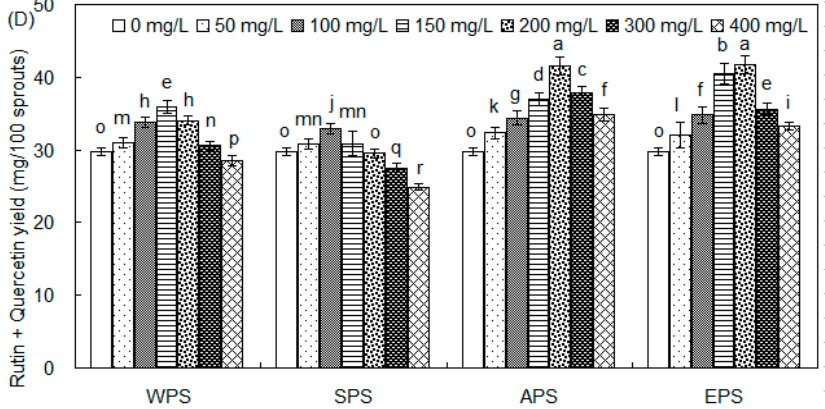
Figure 2. Effects of WPS, SPS, APS and EPS (0, 25, 50, 100, 200 and 400 mg/L) of endophyte F. oxysporum Fat9 on the total flavonoid content ( A ), rutin content ( B ), quercetin content ( C ), and total rutin and quercetin yield ( D ) of tartary buckwheat sprout cultures ( n = 3). Different letters (i.e., a–q) in each column indicated significant differences among the treatment at p = 0.05 level.